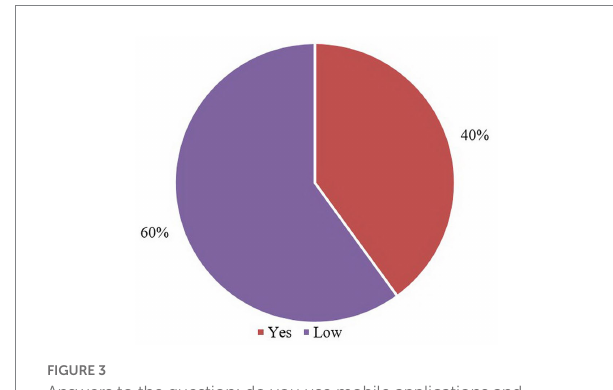
FIGURE 2 Answers to the question: please, rate the level of your technical competence. Source: compiled by the authors.